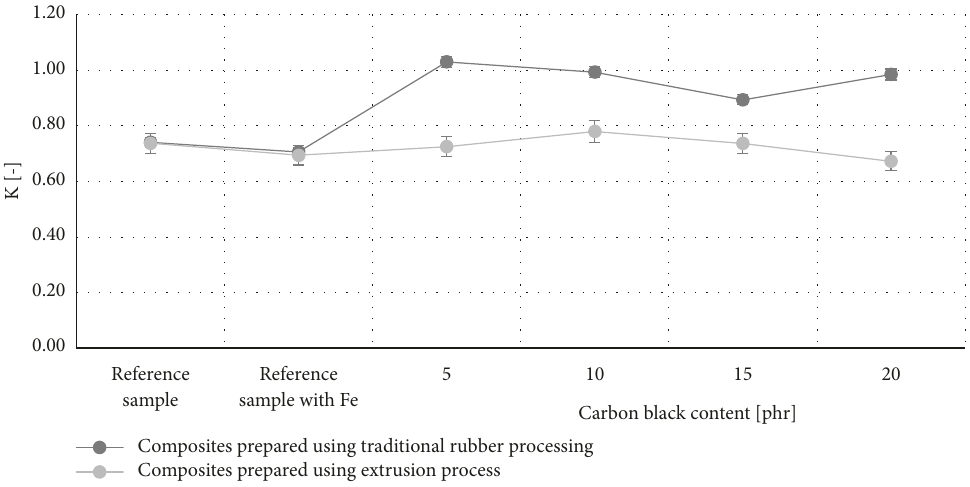
Figure 3: Thermooxidative aging factors of ethylene-octene composites prepared by different producing methods.